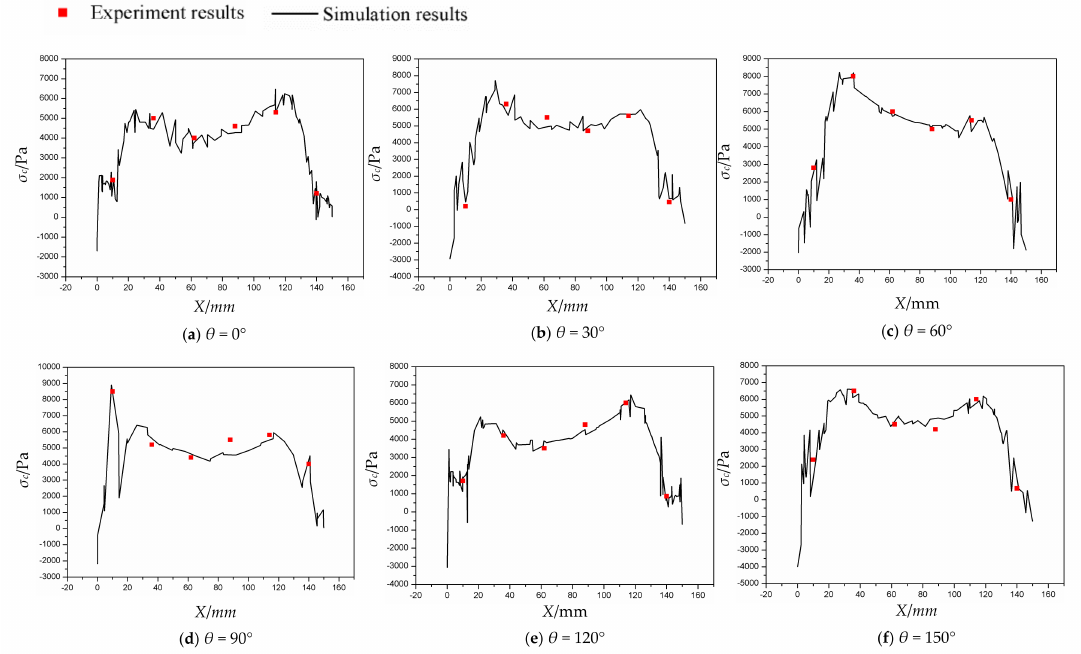
Figure 8. Comparison of the simulation results and experiment results for circumferential component of the principal